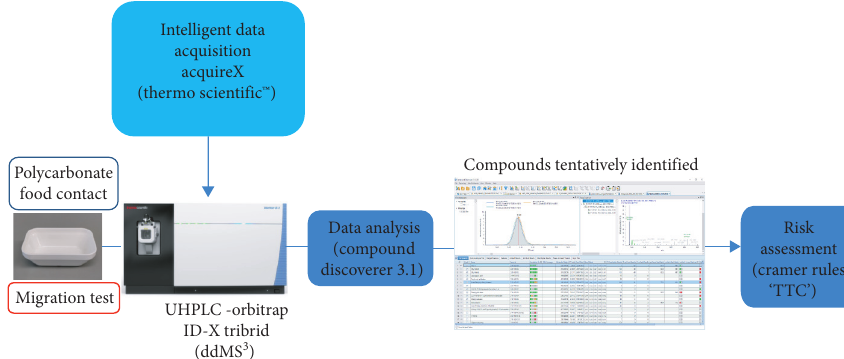
Figure 1: Scheme of the different stages of the presented